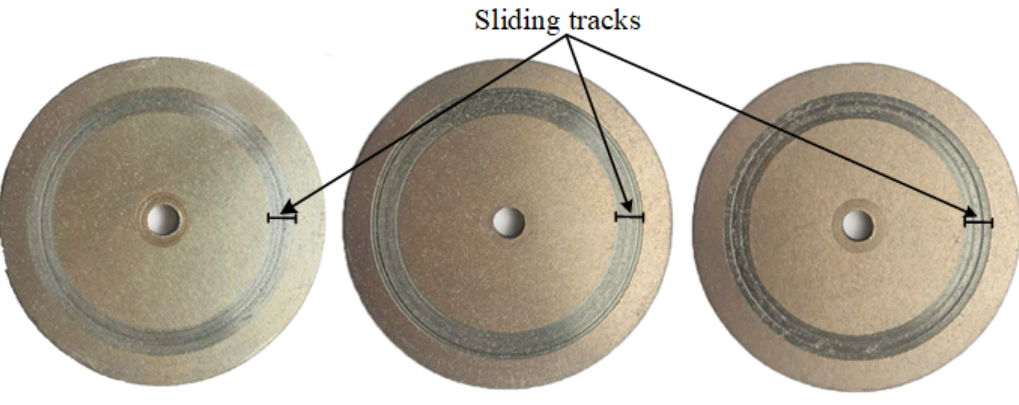
Figure 2. Discs after experiments.